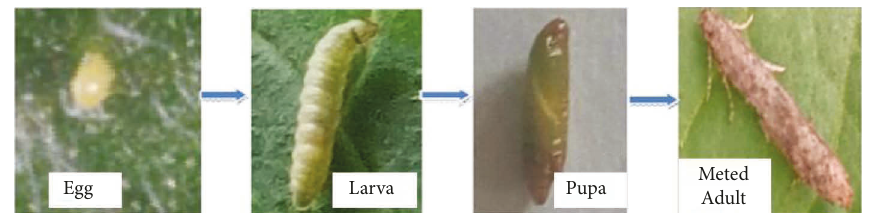
Figure 1: Reproduction process and developmental stage of the Tuta absoluta .